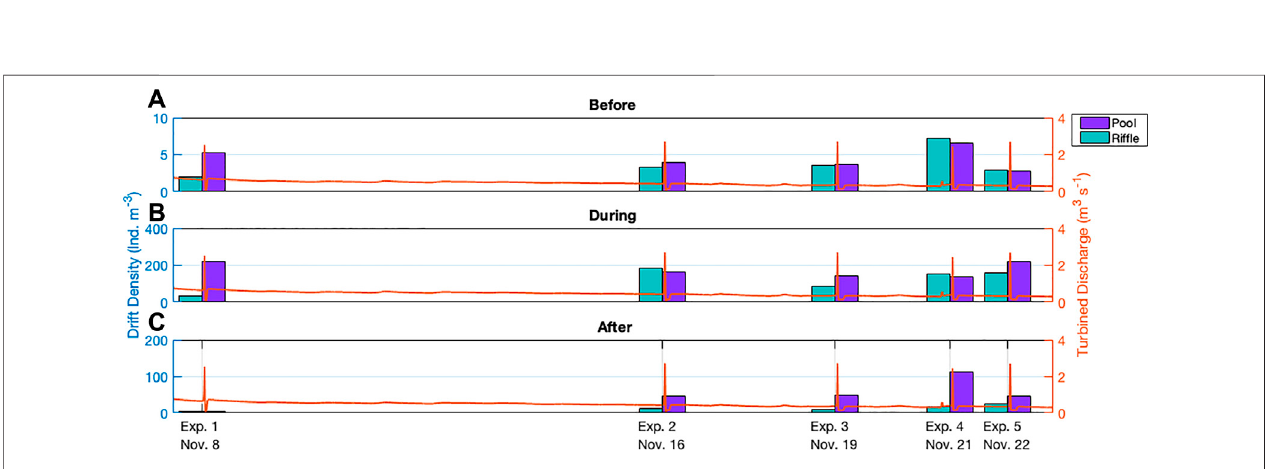
The given abundance corresponds to the sum of all individuals across all nets and sample stages (0 – 5), the density is the abundance divided by the total fi ltered volume.